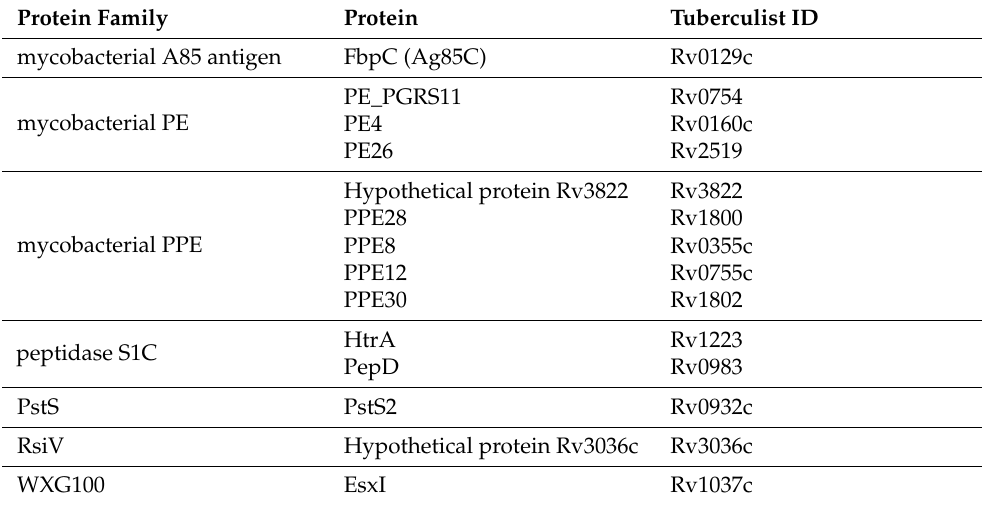
Table 1. Novel Vaxign-ML-predicted PAgs that belong to protein families of established MTB PAgs. Protein